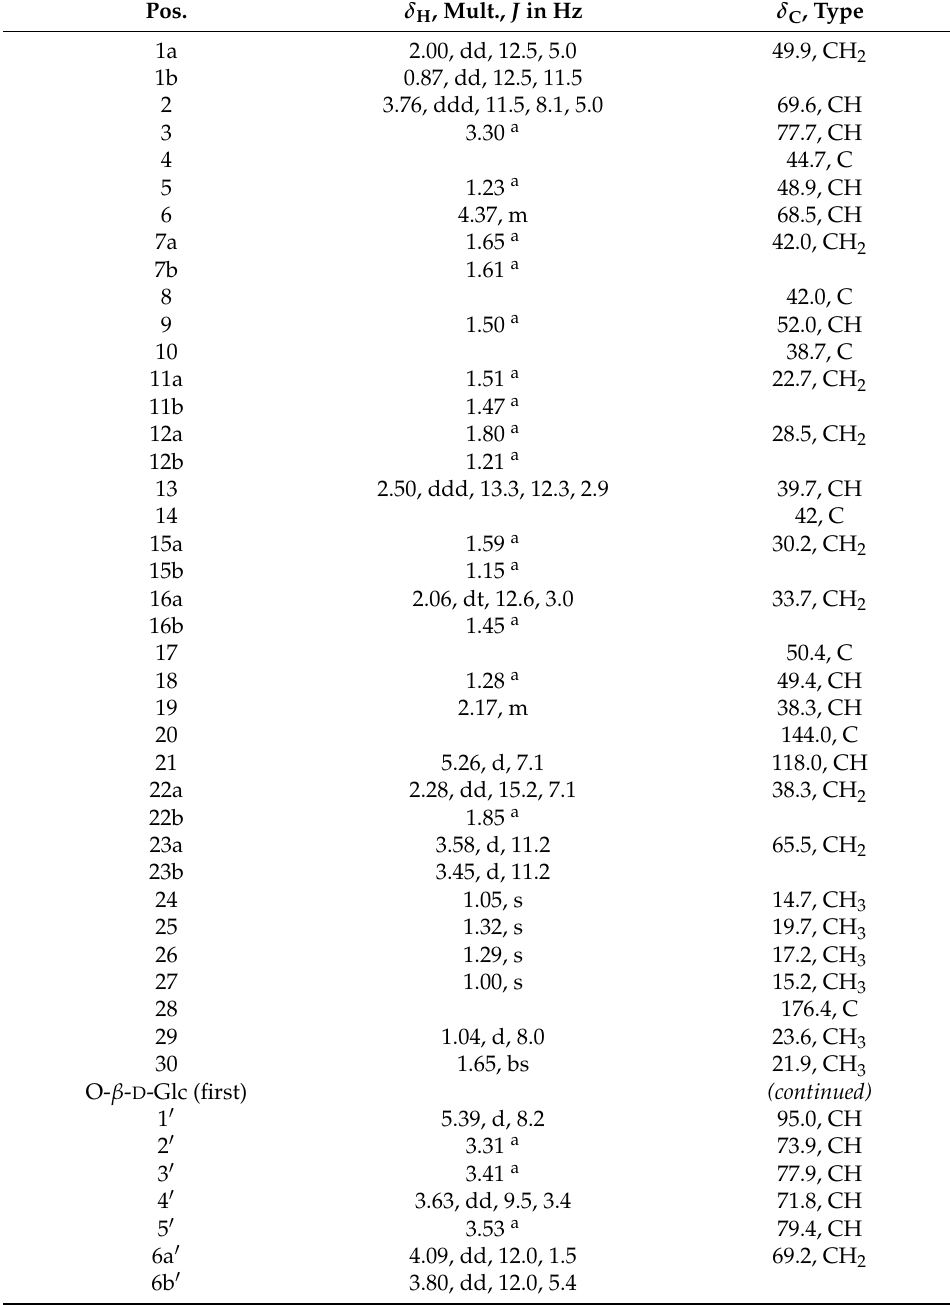
Table 1. 1 H (700 MHz) and 13 C (175 MHz) NMR data of compound 4 in CD 3 OD. Pos. δ H , Mult., J in